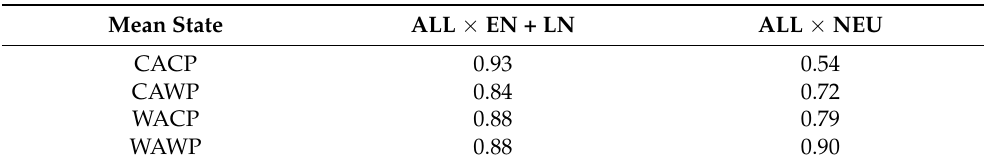
Figure 3. Austral winter SAT anomaly composites of ALL-years during the: ( a ) CACP, ( b ) CAWP, ( c ) WACP, and ( d ) WAWP mean states; of EN + LN-years during the: ( e ) CACP, ( f ) CAWP, ( g ) WACP, and ( h ) WAWP mean states; of NEU-years during the: ( i ) CACP, ( j ) CAWP, ( k ) WACP, and ( l ) WAWP mean states. Continuous contours encompass the significant anomalies at a 90% confidence level using the Student’s t -test. The symbol σ above the colour bar means standard deviation. Table 4. Austral winter pattern correlations for SAT between ALL and EN + LN composites and between ALL and NEU composites in each mean